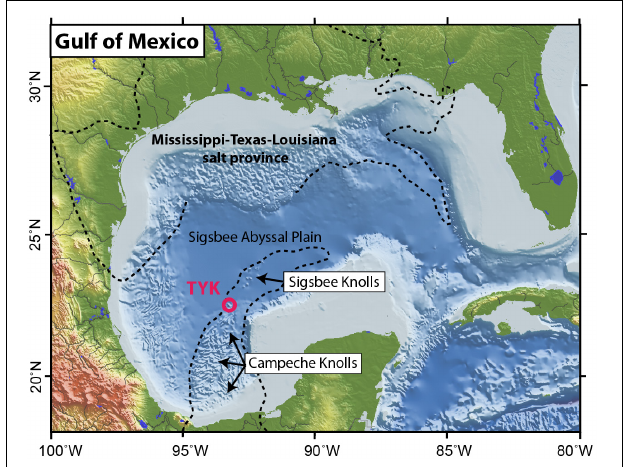
FIGURE 1 | Geomorphological map of the Gulf of Mexico based on shaded GEBCO (General Bathymetric Chart of the Oceans) data showing the position of the Tsanyao Yang Knoll (TYK, red circle) in the southern GOM. Limits of subsurface salt provinces (dashed line) in the northern and southern Gulf of Mexico were adopted from the U.S. Geological Survey (https://catalog.data.